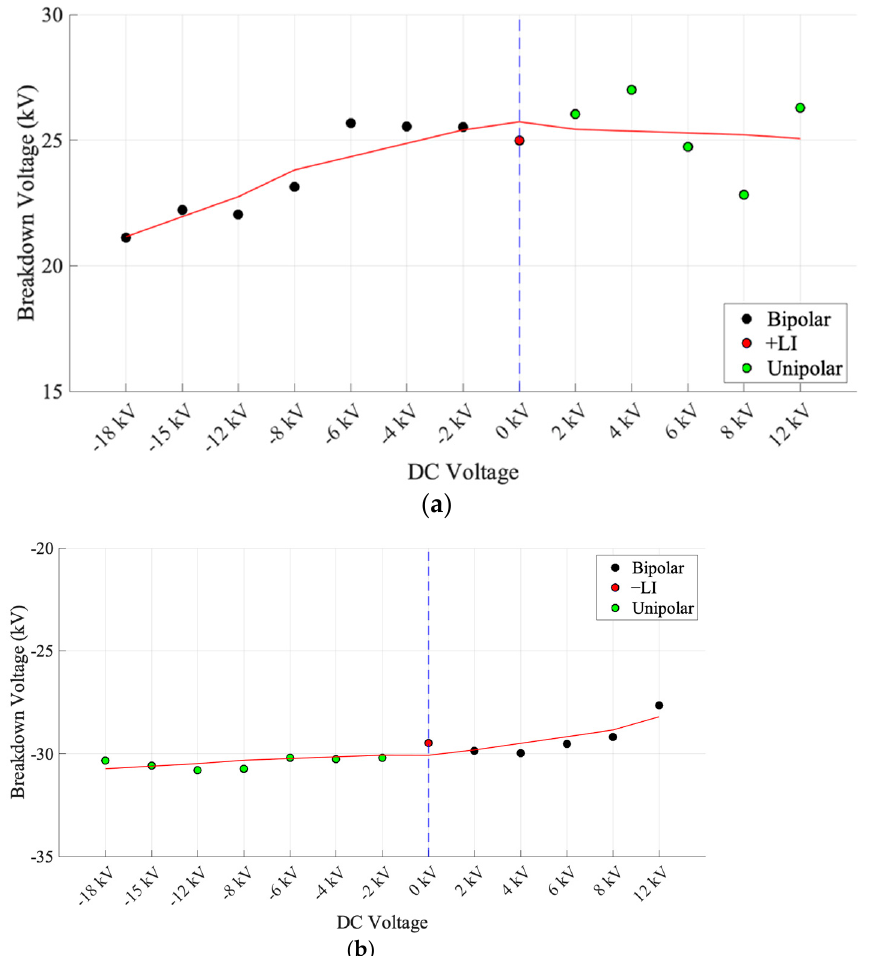
Figure 17. Variation of 50% breakdown voltage for needle–plane electrode system according to different +DC and − DC values: ( a ) +LI; ( b ) − LI.